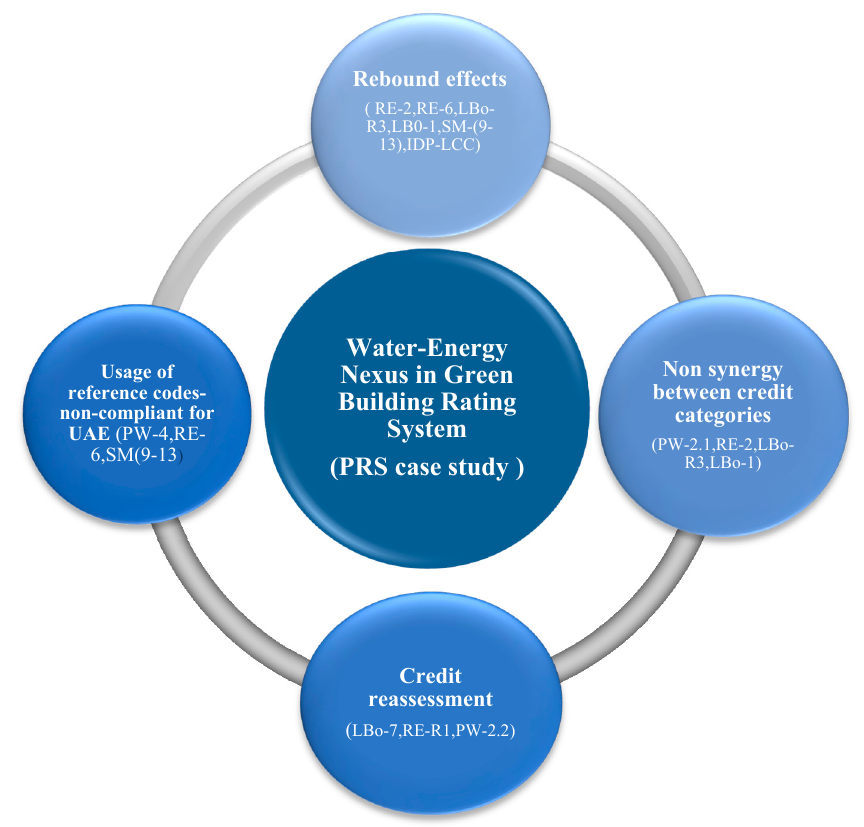
Figure 4. Major identified shortcomings in the Pearl Rating System green building rating system in relation to the water–energy nexus.